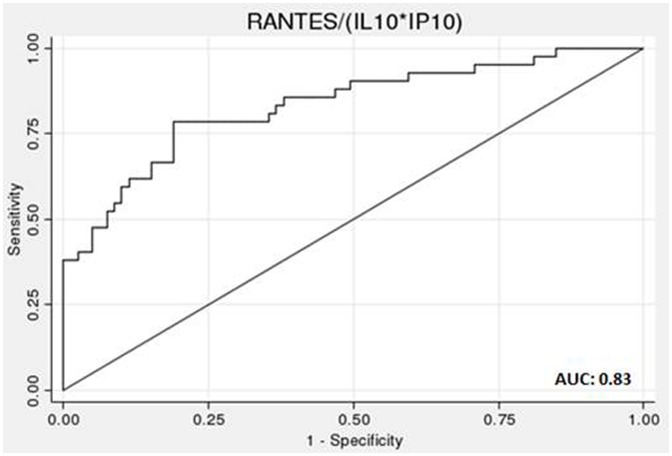
Assessment of biomarkers in predicting P. falciparum infection during pregnancy.Receiver operating curve (ROC) for the multiple logistic regression model, with IL-10, IP-10 and RANTES as predictors. The area under the ROC curve (AUC) with 95% confidence interval is 0.83 (0.75, 0.91).